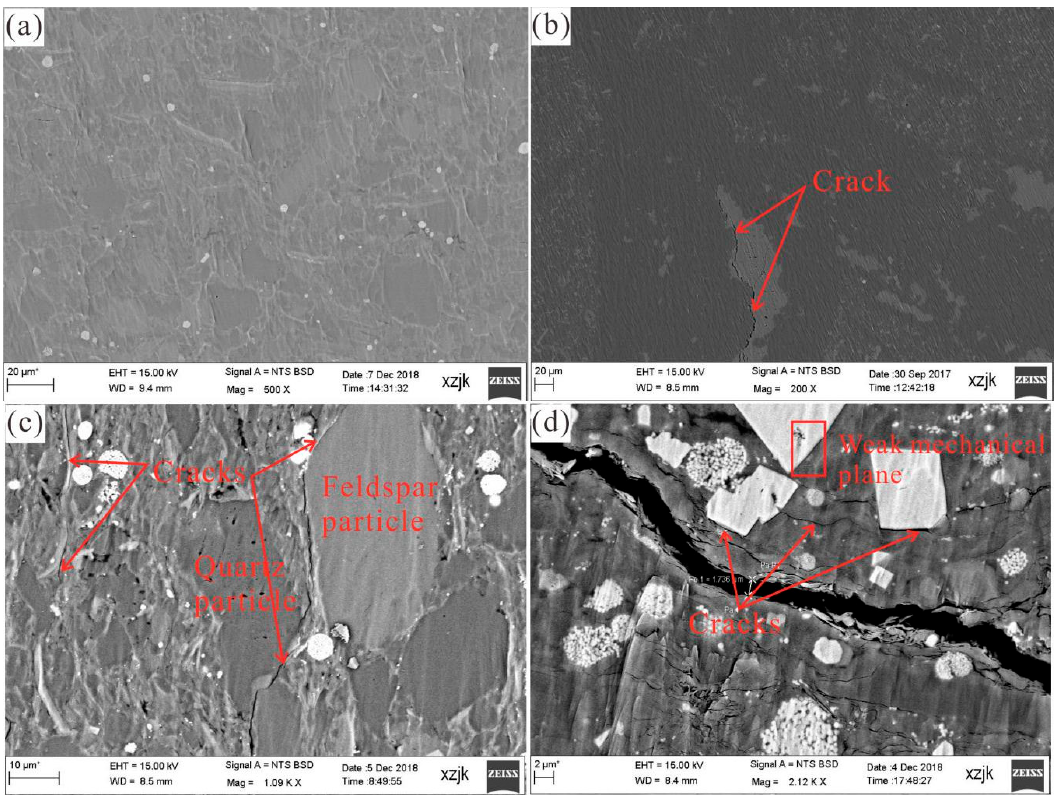
Figure 10. Microstructural characteristics of rock samples in SEM. ( a ) Sample 5 mainly consists of one brittle mineral, and there are few weak structural planes; ( b ) A crack bypasses a particle and extends a short distance around the grain, and then is terminated due to the uniform and compact rock texture in sample 5; ( c ) Sample 4 is made up of appropriate content of various brittle minerals, so there are many weak structural planes between different mineral particles; ( d ) When the crack propagates, it connects the weak structural surface existing along the edge of the grains, leading to a longer distance extension in sample 4.